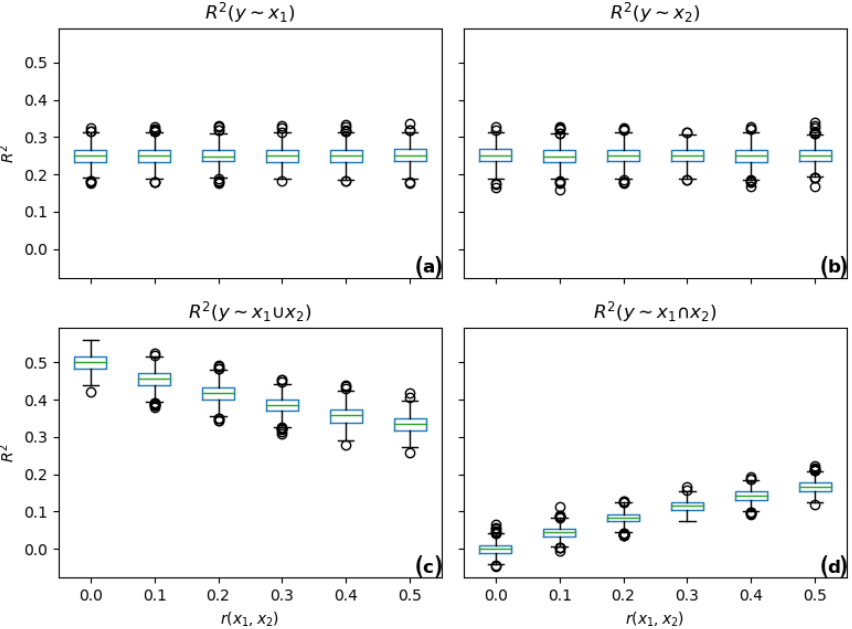
Figure 2. Box plots of coefficient of determination ( R 2 ) for (a) R 2 (y ∼ x 1 ) , (b) R 2 (y ∼ x 2 ) , (c) R 2 (y ∼ x 1 ∪ x 2 ) and (d) R 2 (y ∼ x 1 ∩ x 2 ) in the Monte Carlo